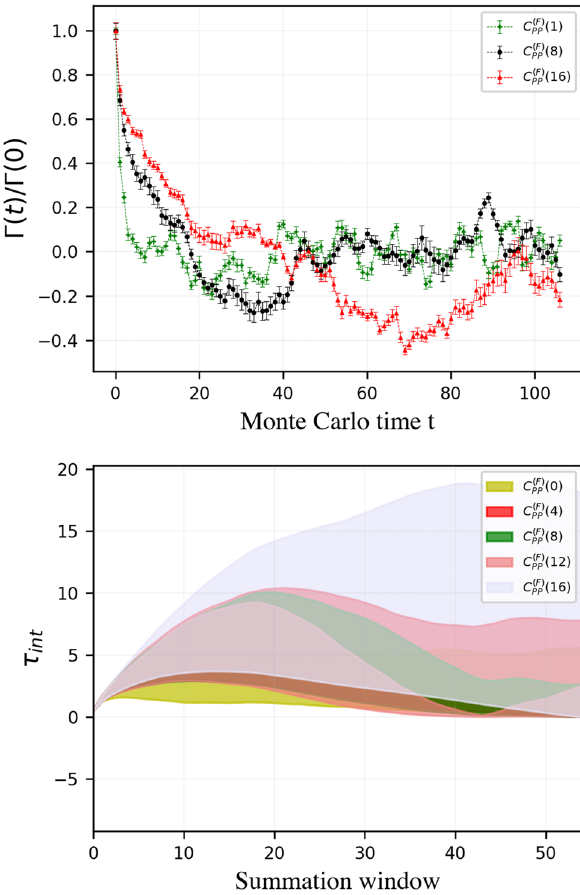
Fig. 15 Top panel: Autocorrelation function Γ ( t )/Γ ( 0 ) computed for the two point function of two pseudoscalar mesons with fermions in the fundamental representation. Different colors represent different inter- vals in lattice time between the source and the sink. Bottom panel: Integrated autocorrelation time as a function of the summation window, computed for the same correlator on the top at several times. The two point function is obtained from the ensemble A0